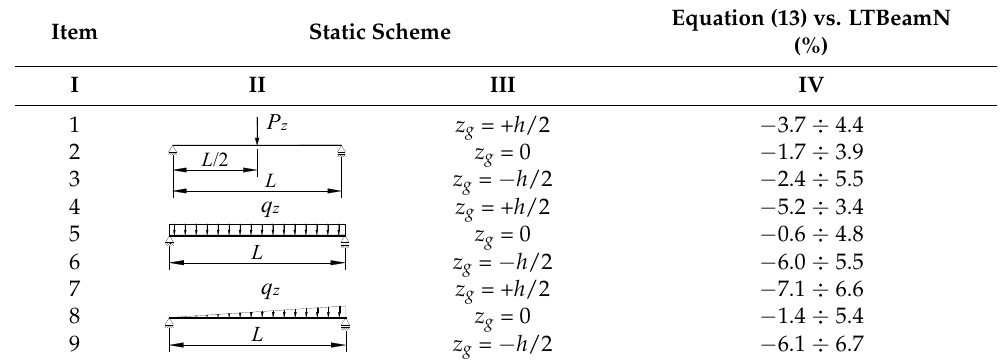
Table 8. Summary of percentage differences of M cr .